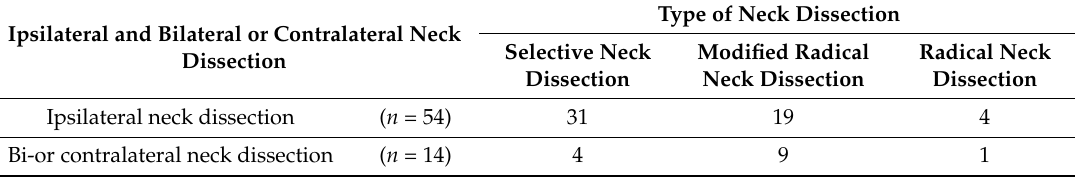
Type of Neck Dissection Selective Neck Modified Radical Radical Neck Dissection Neck Dissection Dissection